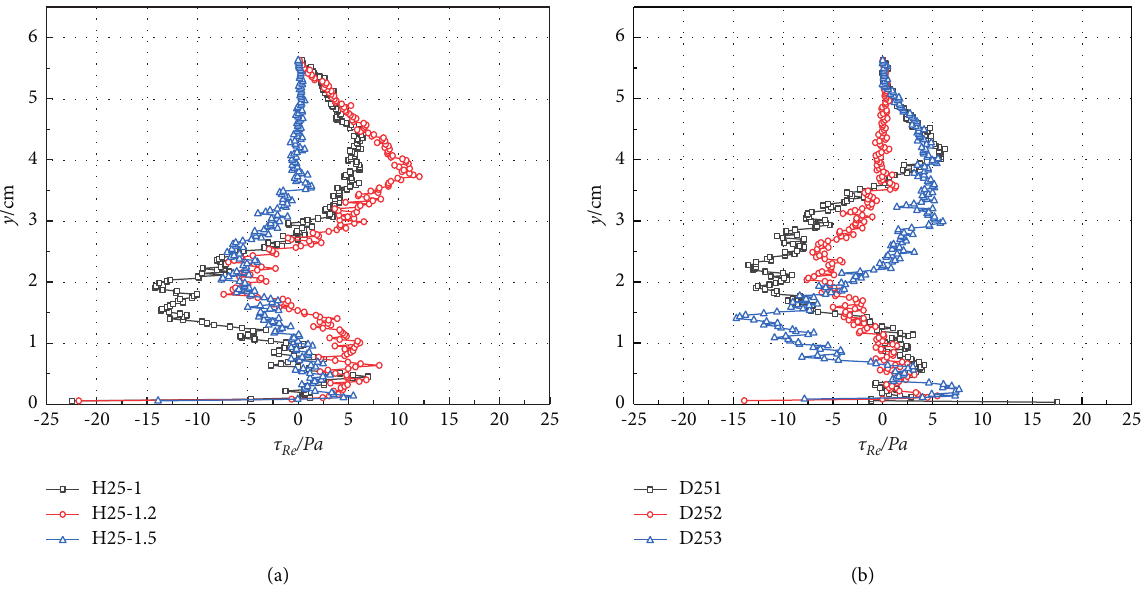
Figure 16: The vertical distribution of Reynolds stress in different working conditions ( x �